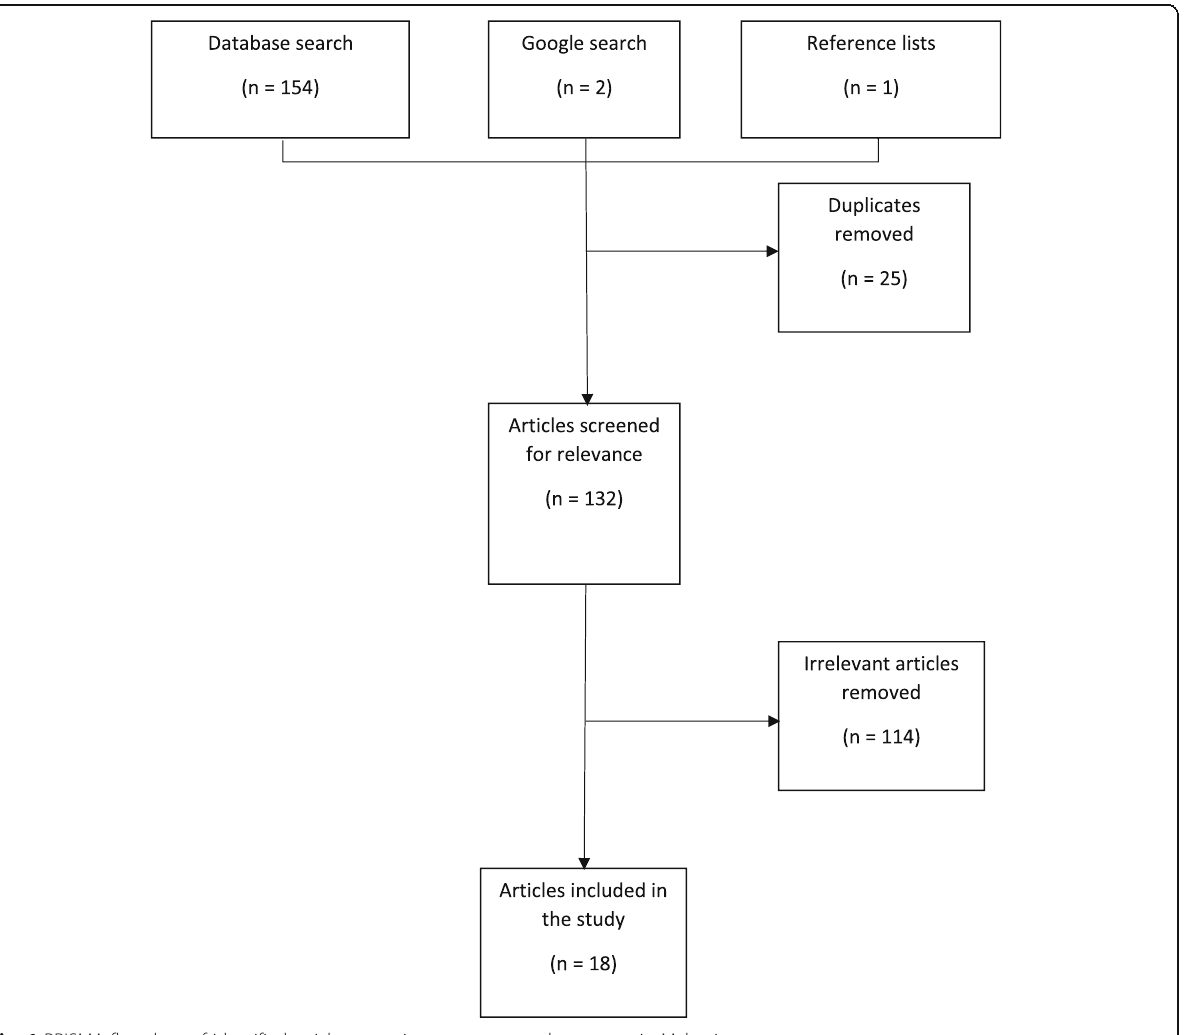
Fig. 1 PRISMA flowchart of identified articles reporting pneumococcal serotypes in